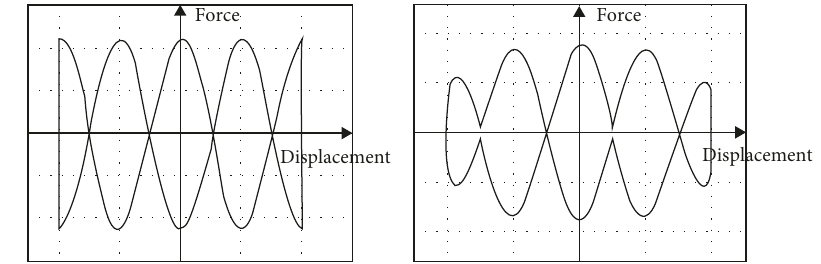
Figure 3: Restoring force-displacement model of CRAD-VD.